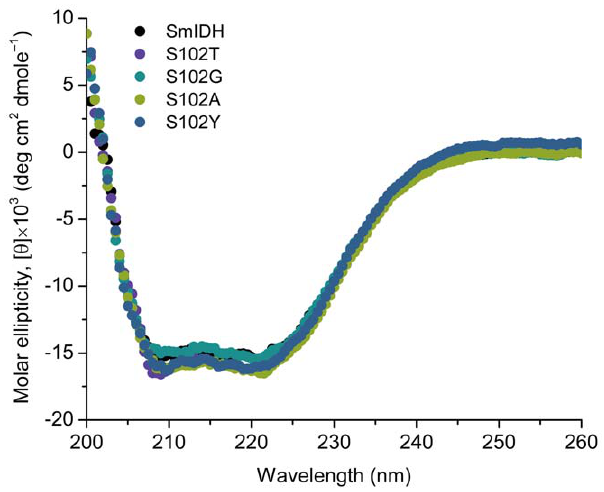
Figure 5. Circular diochroism (CD) spectra of the wild-type SmIDH and four mutants, S102T, S102G, S102A and S102Y. The CD was measured and the molar ellipticity was calculated as described in Materials and